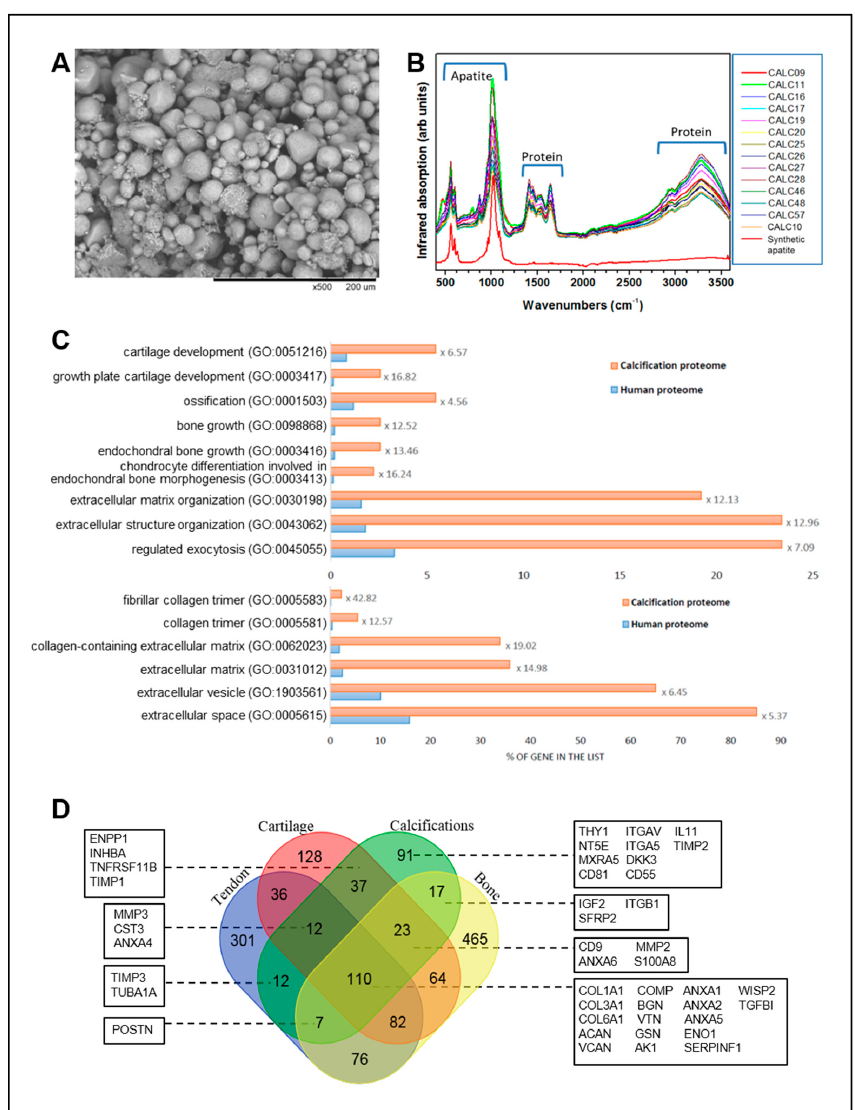
Figure 6. Analysis of the composition of calcifications extracted from patients . ( A ) Electron Microscopy (SEM) of the calcic powder extracted from a representative patient. Scale bar 200 µm. ( B ) Fourier transform infrared (FTIR) spectroscopy of the patients’ calcifications ( N = 14). SHA = synthetic hydroxyapatite. ( C ) Bioinformatic analyses of the protein list identified in calcifications by mass spectrometry-based proteomic analyses ( N = 5). Percentage of genes classified in selected statistically significant GO terms in the total human proteome (blue bars) and in calcifications (orange bars) for biological process (upper panel) and cellular components (lower panel). Enrichment is indicated for each term. ( D ) Comparison of the protein lists compiled for calcifications, bone, tendon, and cartilage using Venn diagram (http: // bioinformatics.psb.ugent.be / webtools / Venn / ). Selected proteins of interest are